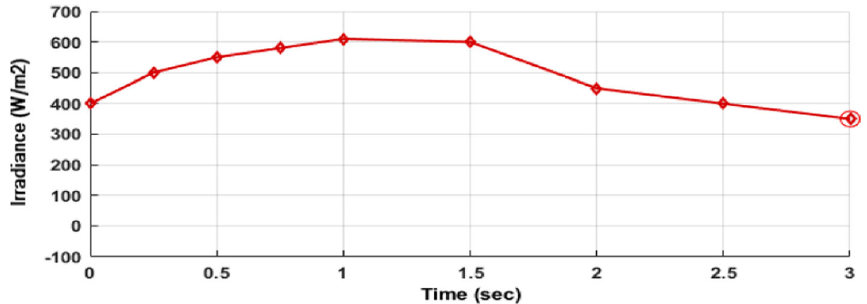
Fig. 15 Solar irradiance waveform